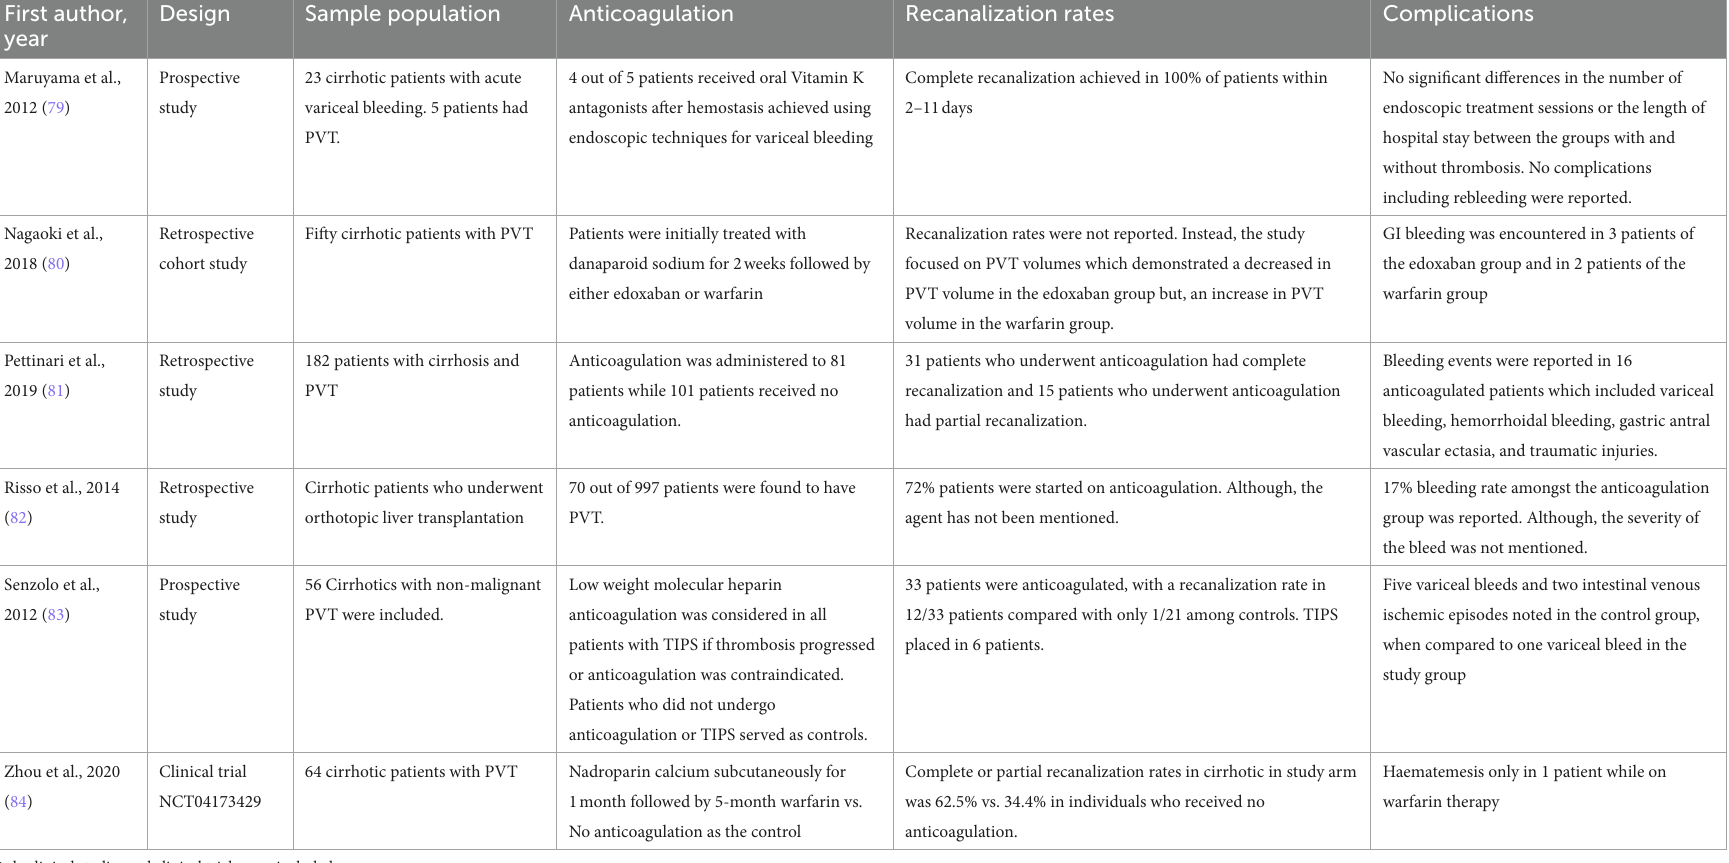
(Upper gastrointestinal